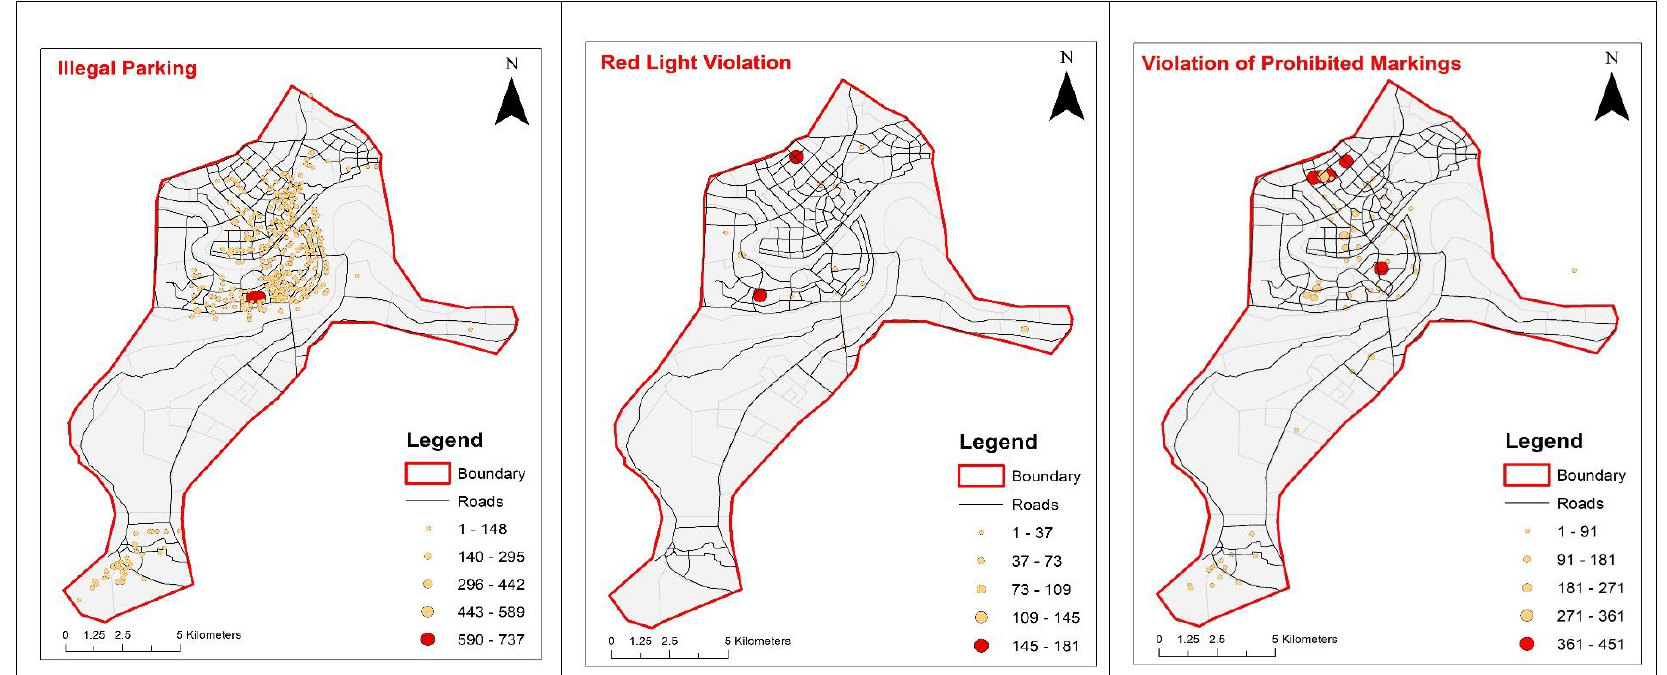
Figure 3. Distribution of hotspots by di ff erent violation